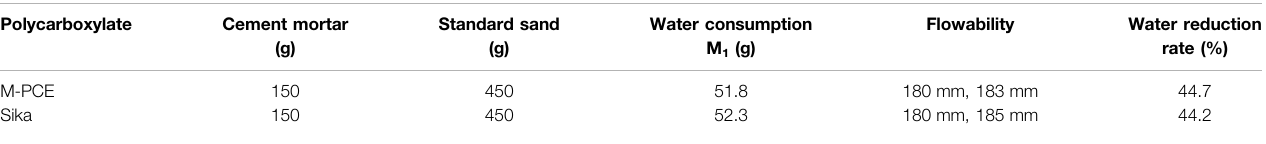
TABLE 3 | Water reduction rate of polycarboxylate in mortar. Polycarboxylate